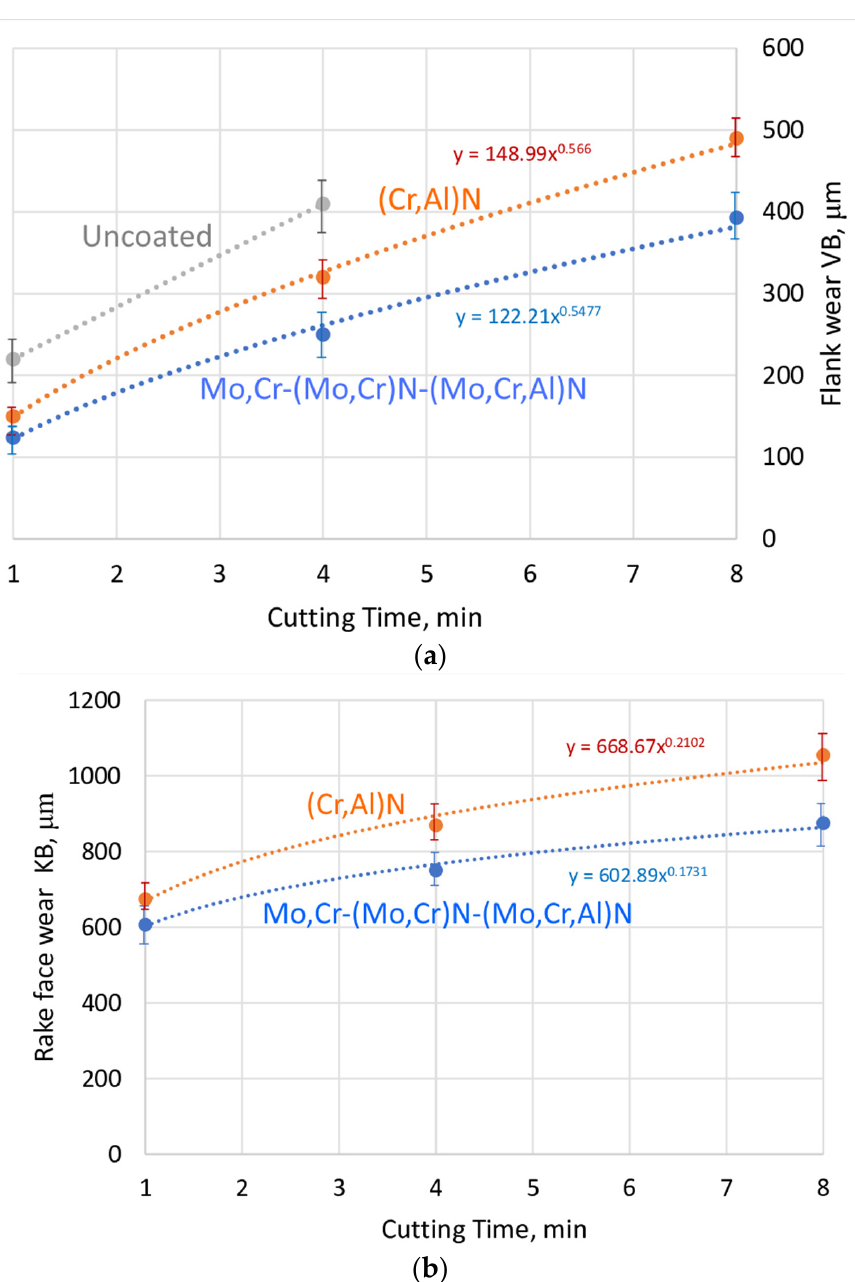
Figure 2. Investigation of tool wear during the turning. ( a ) flank face wear, ( b ) rake face wear. For the more detailed studies of the wear processes on the tool with the Cr,Mo- (Cr,Mo)N-(Cr,Mo,Al)N coating, lamella A (see Figure 3) is cut out, which intersects the coating fracture area on the edge of the wear crater, far from the cutting edge.